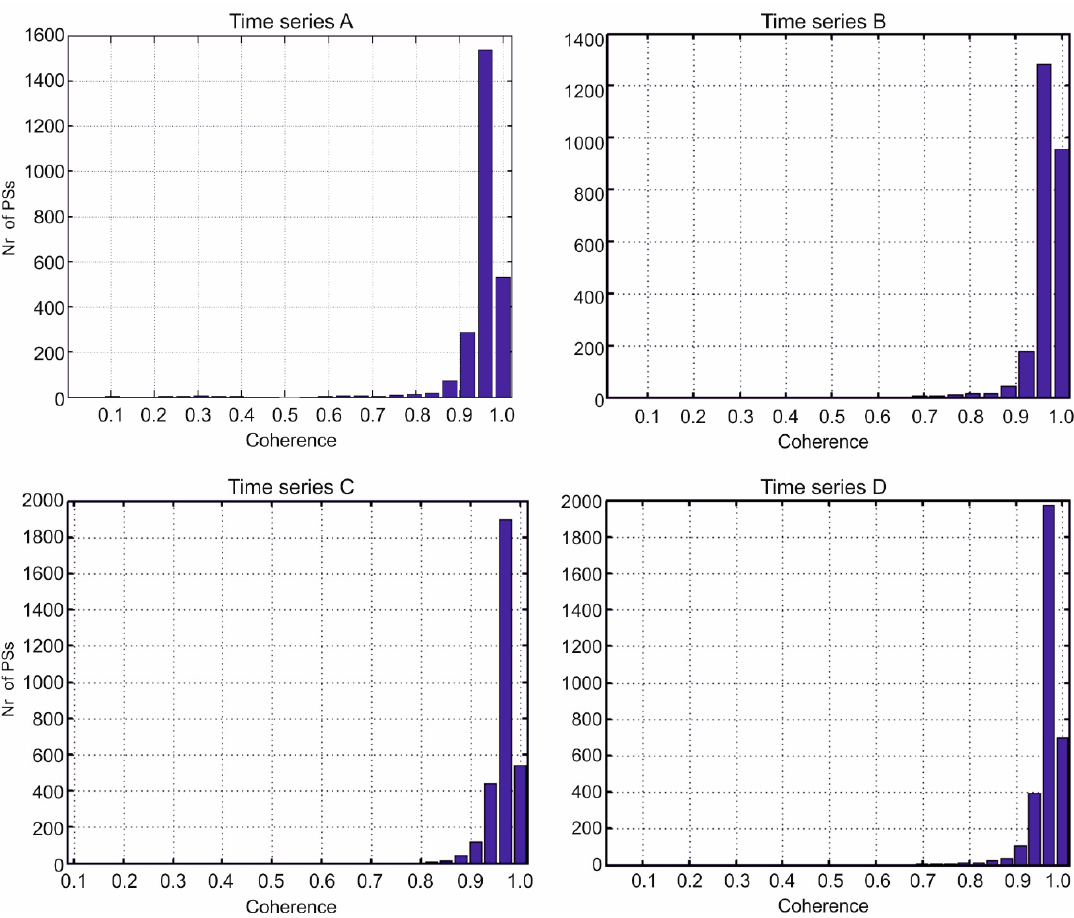
Figure 7. Temporal coherence of selected PSs of time series ( A – D ) after graph inversion and APS Figure7. TemporalcoherenceofselectedPSsoftimeseries( A – D removal.